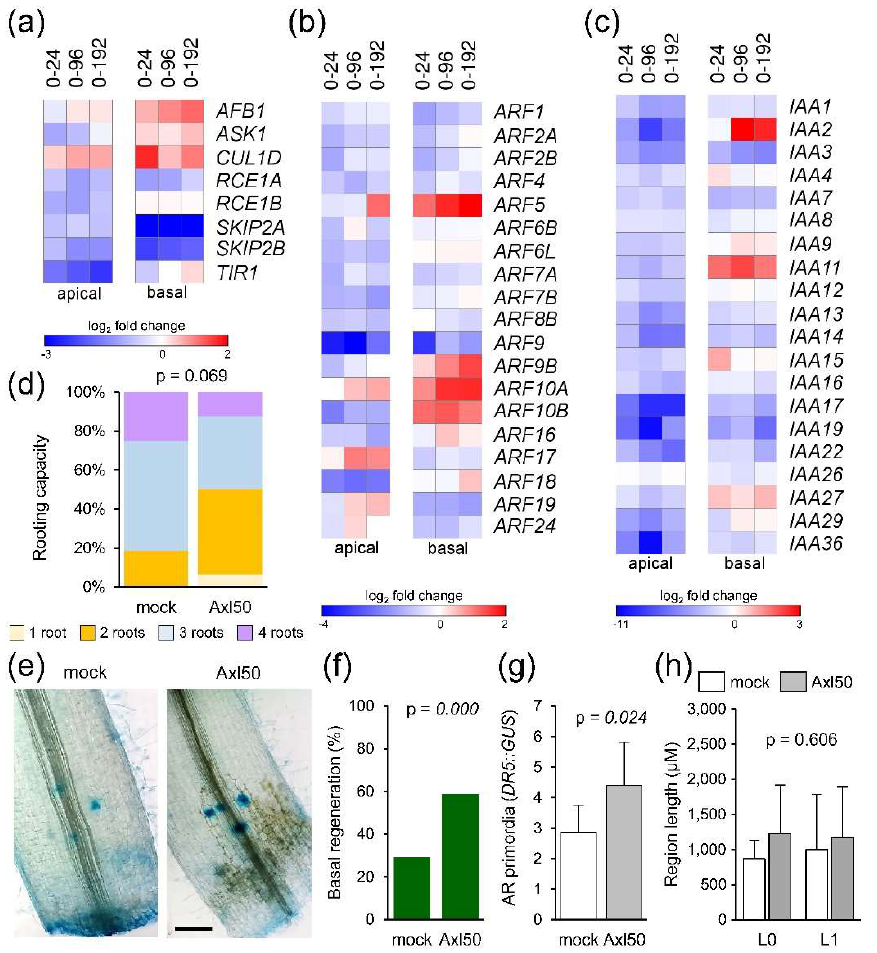
Figure 5. Auxin regulation during de novo organ formation. ( a – c ) DEGs involved in auxin signal transduction: SCF TIR1/AFB function ( a ), ARF family ( b ), and the Aux/IAA family ( c ). Expression values of DEGs (FDR < 0.01) were in log 2 fold change relative to 0 hae according to the scale bars in the figure. ( d ) Rooting capacity of whole (DCBA) hypocotyl explants at 14 dae; explants were incubated with 50 µM auxinole (Axl50) for 48 h. ( e ) Representative images of DR5::GUS expression in the hypocotyl explants after 48 h of mock or 50 µM auxinole (Axl50) treatment. ( f , g ) Regeneration response ( f ), and AR primordia expressing DR5::GUS ( g ) at 48 h after mock or 50 µM auxinole (Axl50) treatment. ( h ) Length of the distance to the wounding (L0) and of the AR formative region (L1) at 48 h after mock or 50 µM auxinole (Axl50) treatment. Scale bars in e: 500 µm.